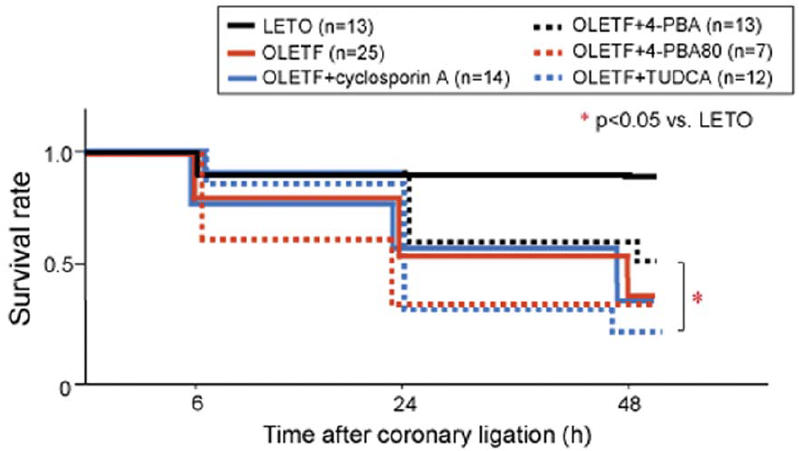
Figure 6. Survival after myocardial infarction. Kaplan-Meier survival analysis of rats with acute myocardial infarction. *p , 0.05 vs. LETO. 4-PBA = pretreatment with 4-PBA at dose of 40 mg/kg/day; 4-PBA80= pretreatment with 4-PBA at a dose of 80 mg/kg/day; Cyclosporine A = pretreatment with cyclosporine A at dose of 20 mg/kg/day; TUDCA= pretreatment with sodium tauroursodeoxycholic acid (100 mg/kg/day). All agents were administered intraperitoneally for 7 days before infarct experiments. Experiments using TUDCA and a higher dose of 4-PBA (i.e., 4-PBA80 group) were additionally performed as post-hoc experiments.